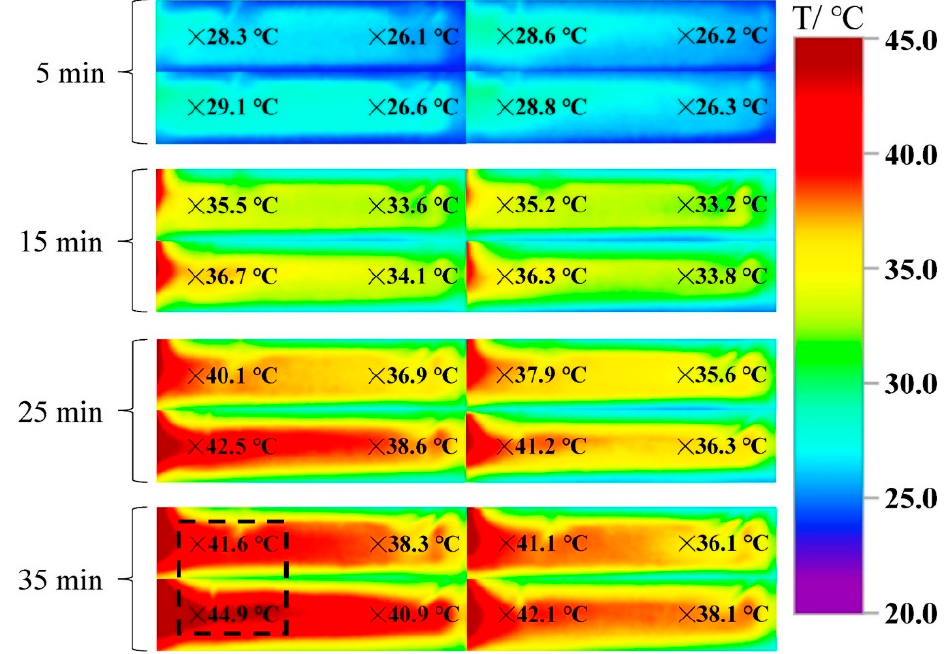
Figure 5. Temperature values on the adiabatic sections covered with the pure paraffin (up) and CuO/paraffin (down) under fan voltages 5 V (left) and 10 V (right), using an infrared thermal imager.